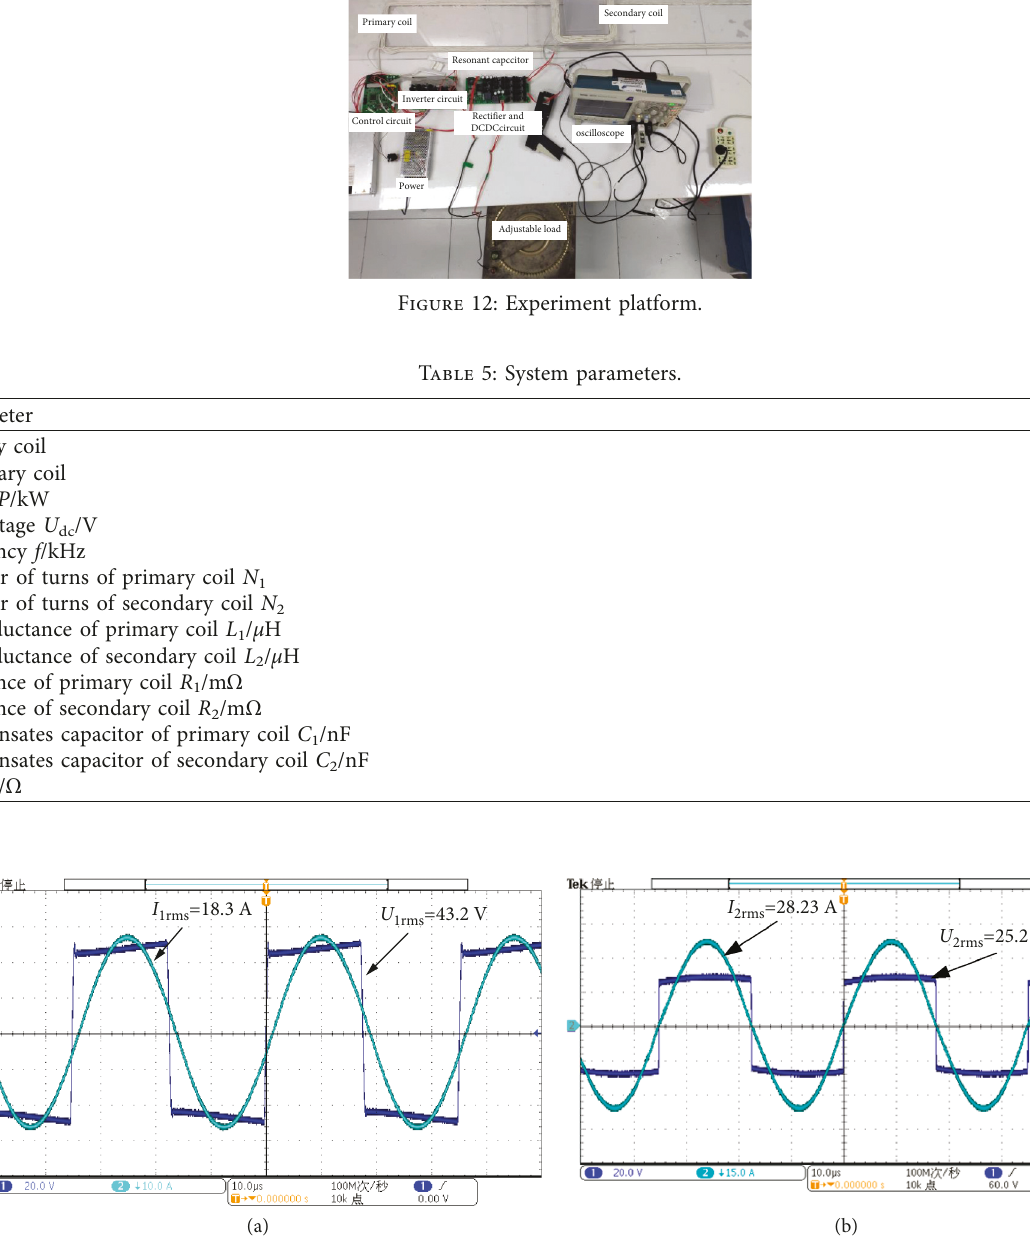
Figure 13: Coupling coil voltage and current waveform of the coupling mechanism at 3cm air gap. (a) Primary coil voltage waveform and current waveform. (b) Secondary coil voltage waveform and current